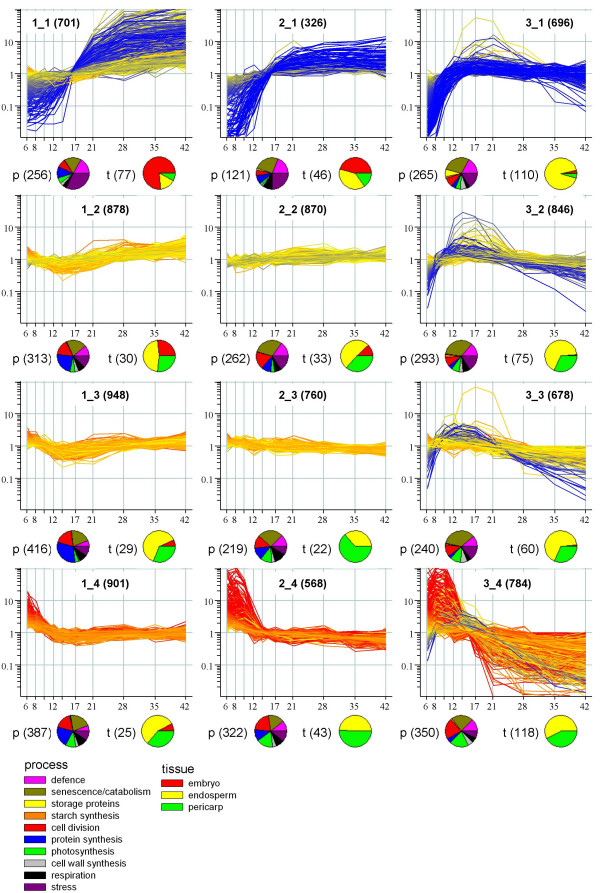
Day of anthesis versus normalised expression of probesets grouped into clusters according to their expression profiles by Self-Organising Map algorithm. Each graph represents a different cluster and at the top of the graph the cluster name (which is the position in the map) is shown along with the number of probesets it contains in parentheses. Pie chart classifications for biological process and tissue category were inferred from various sources (see Methods). Unclassified probesets were omitted from the pie charts: the number that were classified are shown in parentheses next to the chart.